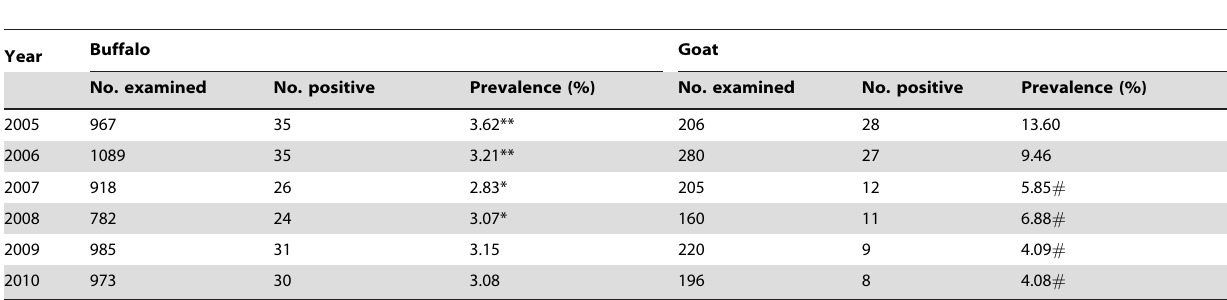
Table 3. Prevalence of S. japonicum infection in buffalo and goats from Matang Town.